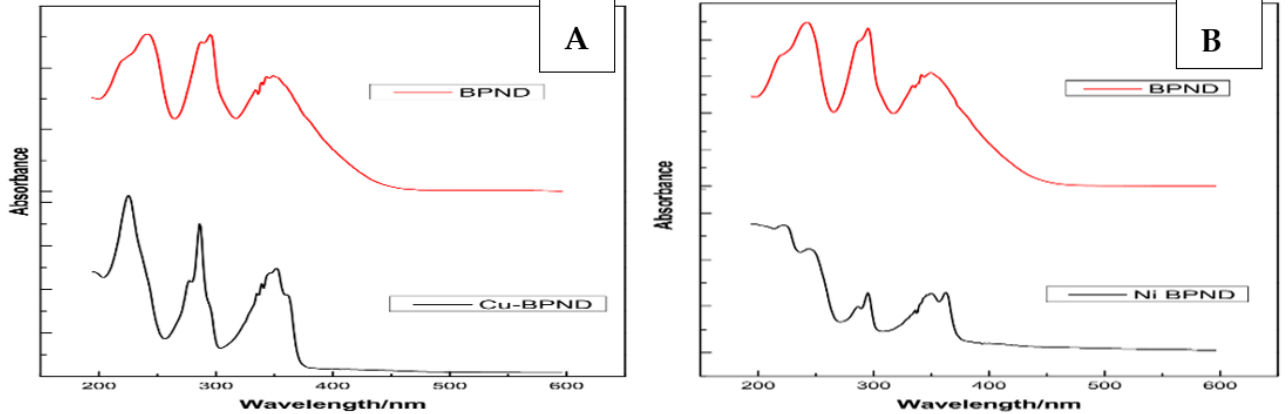
Figure 3. Electronic spectra for BPND free ligand and Cu-BPND complex ( A ) and BPND free ligand and Ni-BPND complex ( B ). Ethanol was used as a solvent for both complexes.